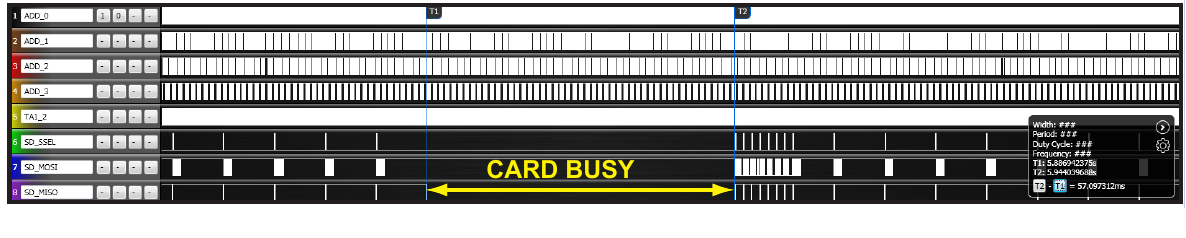
Figure 10. 57 msec. delay with Kingston SD